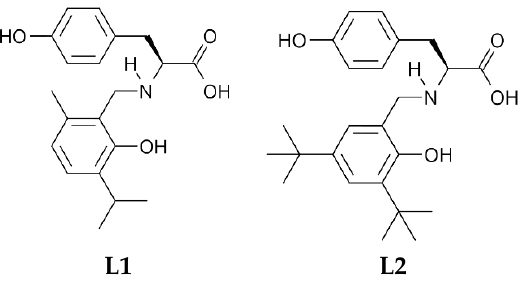
Figure 1. Proposed structural formulas of the L-tyrosine derivatives L1 and L2 .